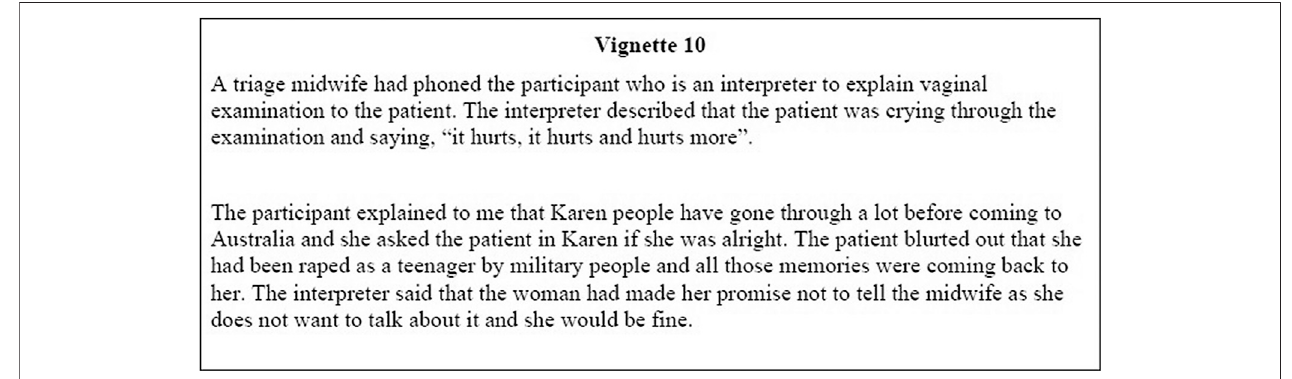
FIGURE 10 | Excerpt from fi eld notes written after an intensive interview with a Karen